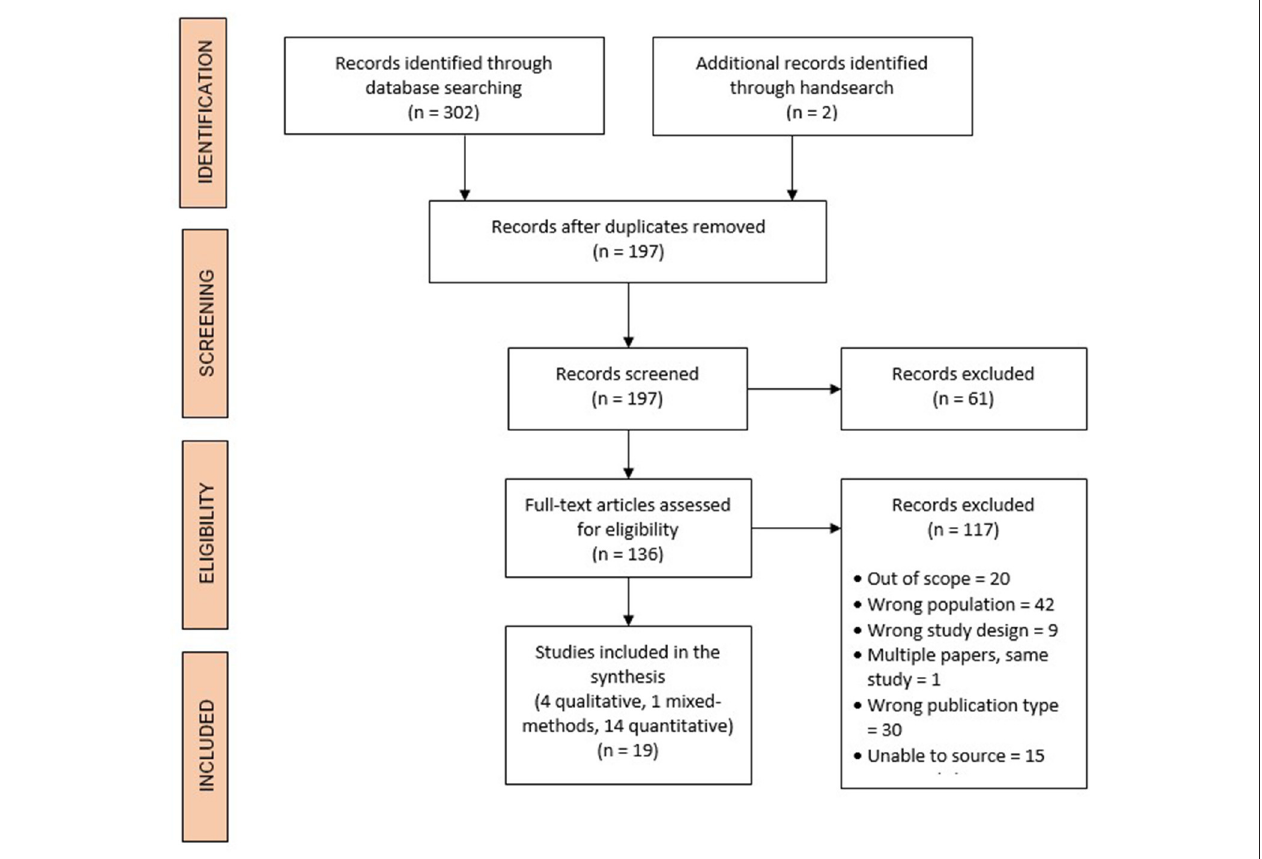
FIGURE 1 | Study selection and PRISMA (Preferred Reporting Items for Systematic Reviews and Meta-Analyses) flow